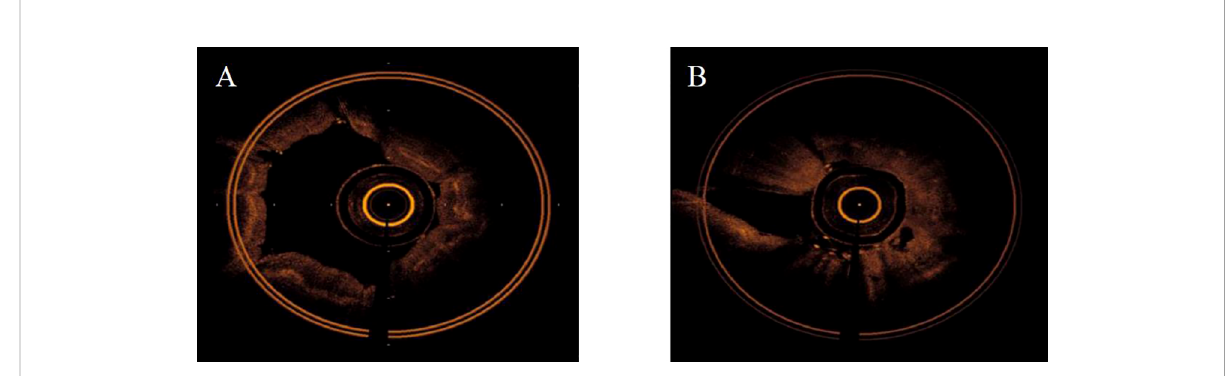
FIGURE 1 The main OCT feature of benign and malignant bronchial lesions. (A) : benign bronchial lesions. (B) : malignant bronchial lesions.